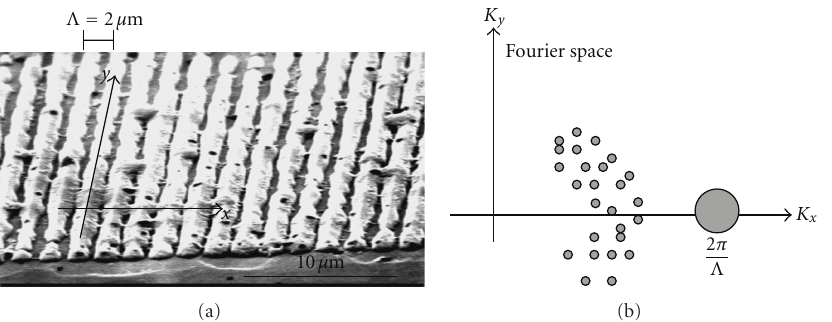
Figure 1: (a) Micrograph of an SPP-LT sample after chemical etching; a nonuniform mark-to-space ratio is visible in the poled area with 2- μ m period. (b) Fourier spectrum of the nonlinear distribution shown in